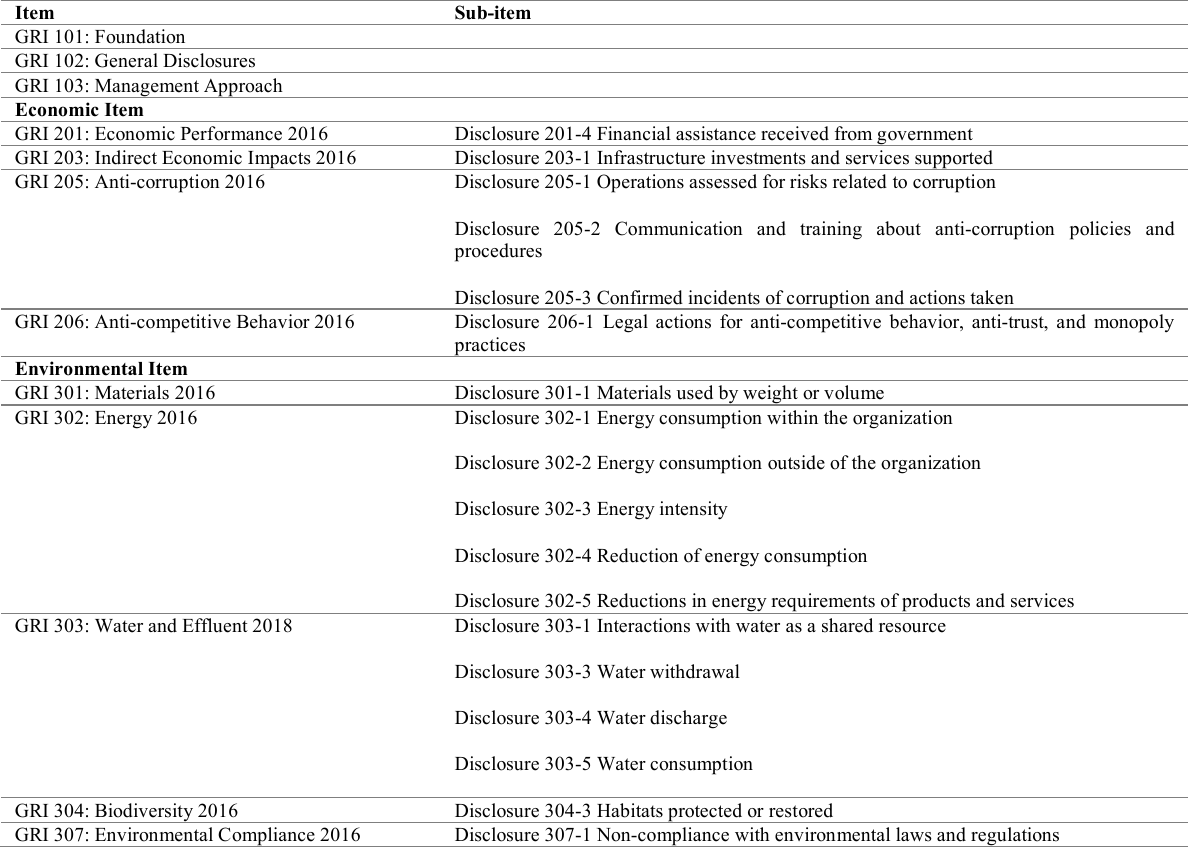
Table 8 . Faculty Sustainability Report